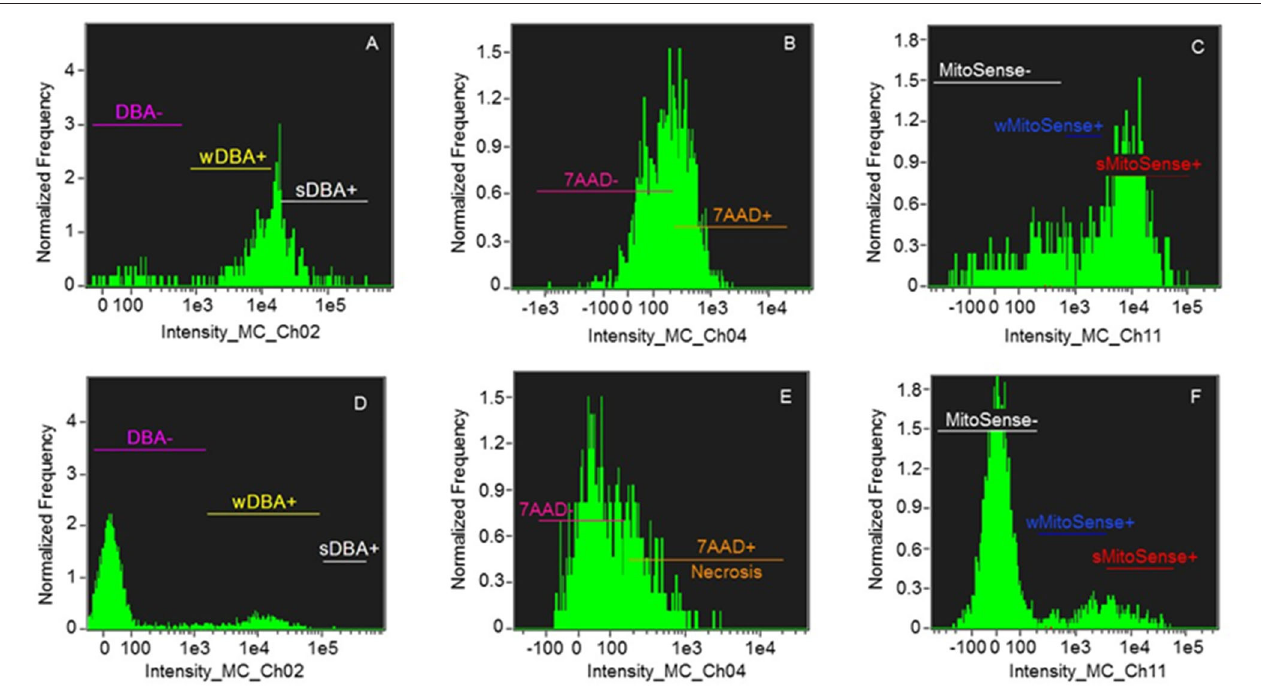
FIGURE 2 | Histograms of samples of Group 1: > 30% sMitoSense + (A–C) and Group 2 < 30% sMitoSense + (D–F) . (A,D) DBA histograms showing strongly DBA-positive (sDBA + ) cells corresponding to SSC, weakly DBA-positive (wDBA + ) cells corresponding to early differentiating SSC, and DBA-negative (DBA-) cells corresponding to differentiated round spermatogonia. (B,E) Histograms of necrotic cells (7AAD + ). (C,F) Histograms of cells with intact mitochondrial membranes (sMitoSense + ), weakly MitoSense-positive (wMitoSense + ) cells, undergoing early apoptosis, and MitoSense-negative (MitoSense − ) cells.